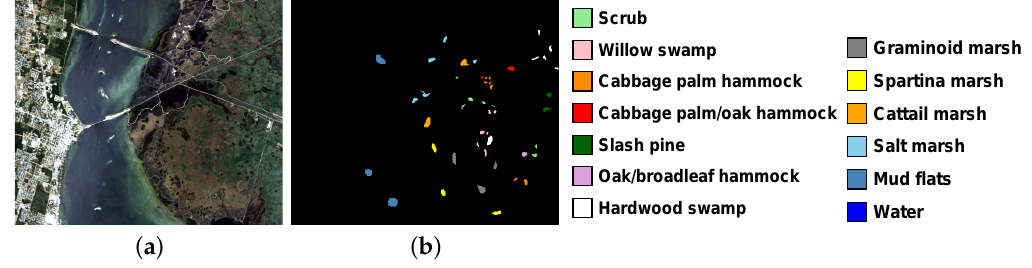
Figure 4. AVIRIS Kennedy Space Center dataset. ( a ) RGB composite image. ( b ) Ground reference map.